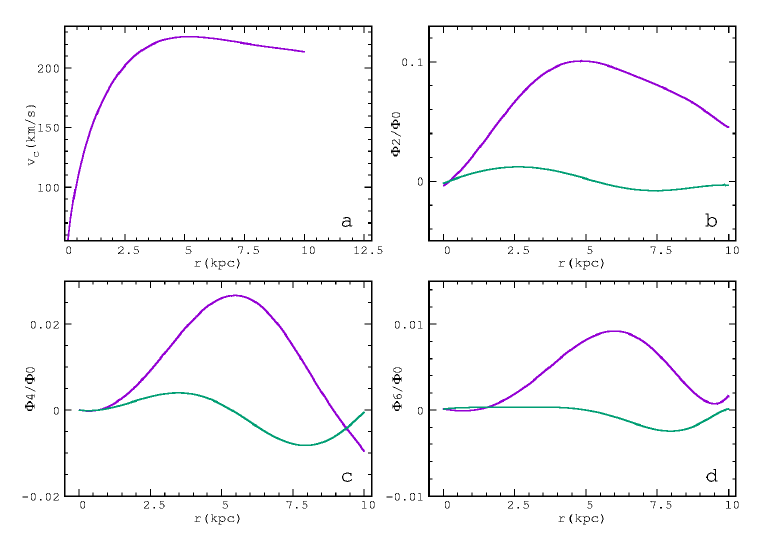
(cid:113) Φ r d ( a ) and the k = 2 ( b ), k = 4 ( c ) and k = 6 ( d ) components of 0 dr